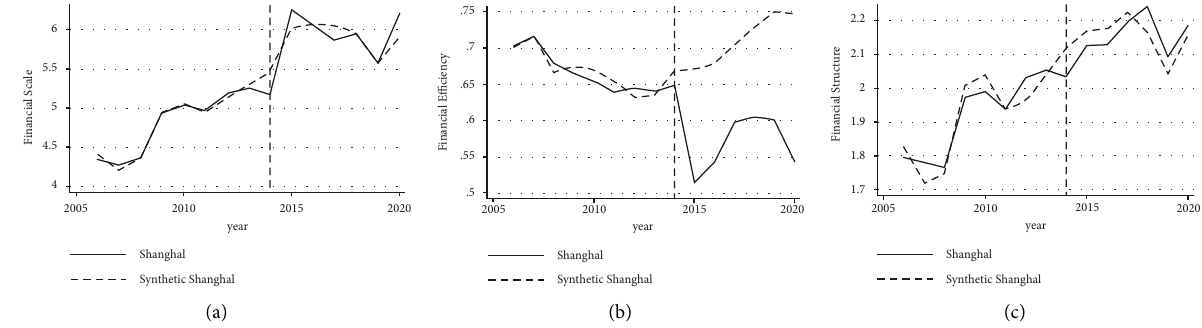
Figure 7: Placebo test: Shanghai and synthetic Shanghai. (a) Financial scale. (b) Financial efficiency. (c) Financial